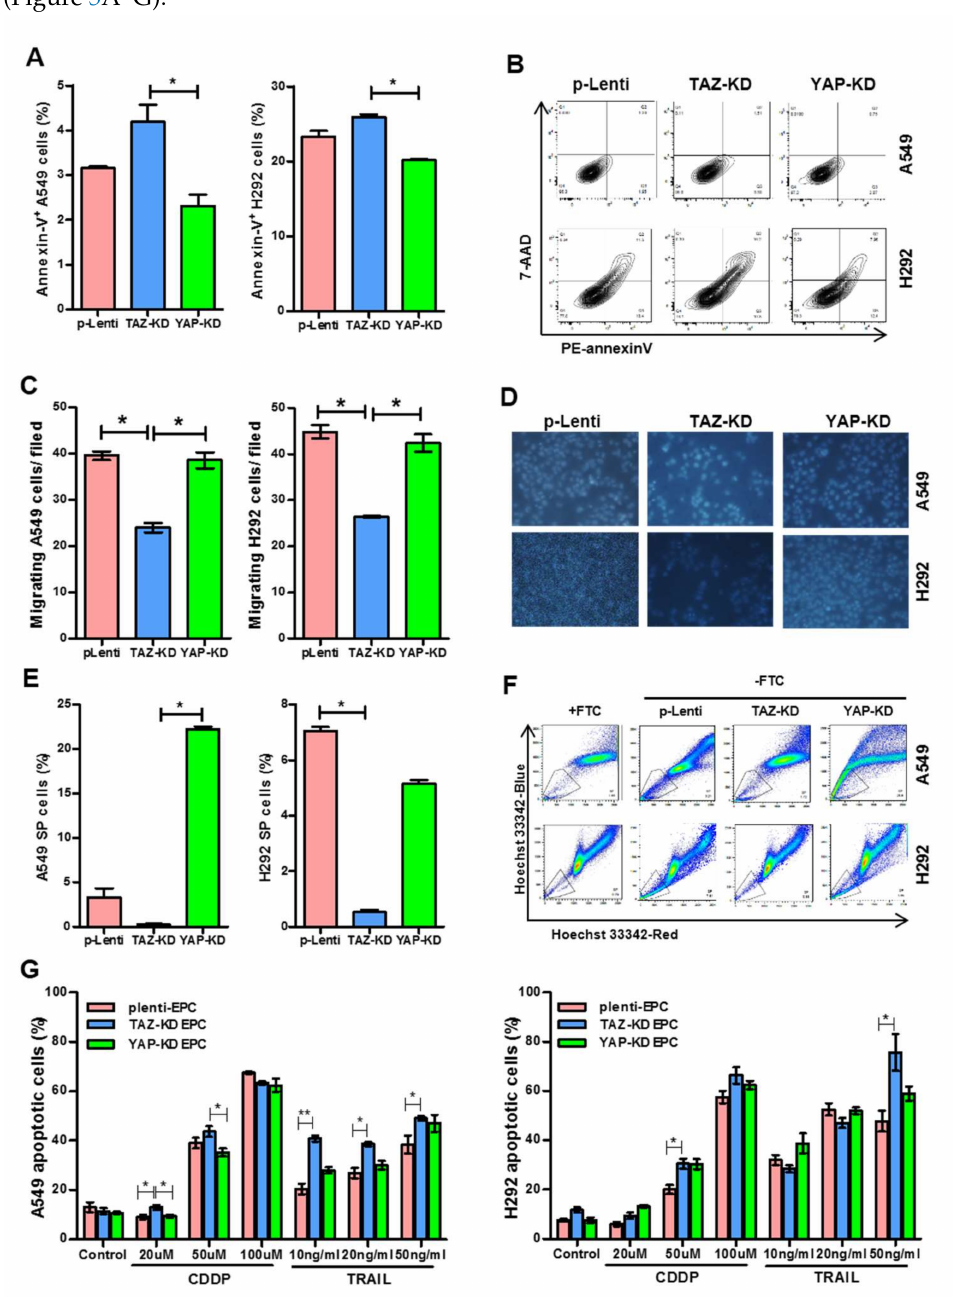
Figure 5. Treatment of lung cancer cell lines with conditioned medium from TAZ- or YAP-KD EPCs. Confluent NCI-A549 and H292 cell lines were exposed with a conditioned medium from EPCs for 24 h. Apoptosis detection ( A , B ), cell migration ( C , D ), and side population ( E , F ) were determined by annexin-V/7-AAD staining, Transwell assay, and Hoechst exclusion in the presence and absence of fumitremorgin C (FTC), respectively. A549 and H292 lung cancer cells cultured in an EPC- conditioned medium were treated with cisplatin (CDDP) and TRAIL, the apoptosis inducers, at indicated concentrations for 24 h. Apoptotic lung cancer cells were counted by Hoechst 33,342 staining of cells that have condensed or fragmented nuclei ( G ). All experiments were performed three times independently with technical duplicates, and data were expressed as mean ± SEM. * p -value < 0.05; and ** p -value <